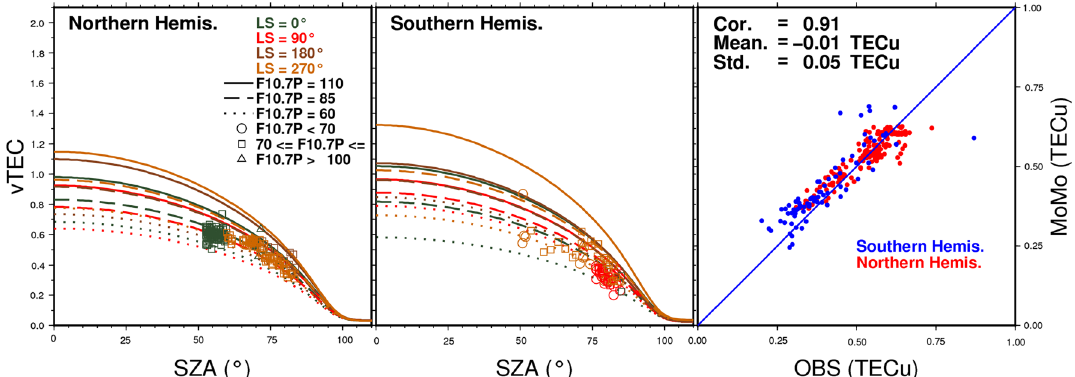
Fig. 5. MoMo empirical model results for the Northern (left) and Southern (middle) hemispheres. The colours correspond to the different seasons (i.e., Ls); the solid, dashed and doted lines represent high, moderate and low solar activity level respectively. Also represented are the radio occultation data (Peter et al., 2014) for different solar activity levels: high (triangle), moderate (square) and low (circle). On the right is the scatter plot showing the MoMo prediction model versus the vTEC from the Mars Express radio occultation data for the two hemispheres.